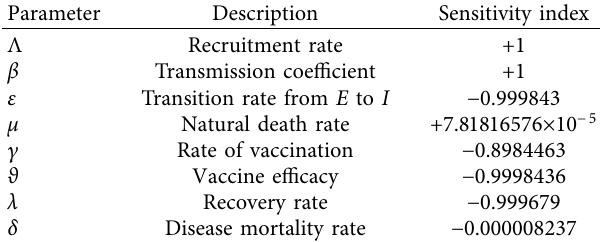
Table 1: Sensitivity indices of R parameters.